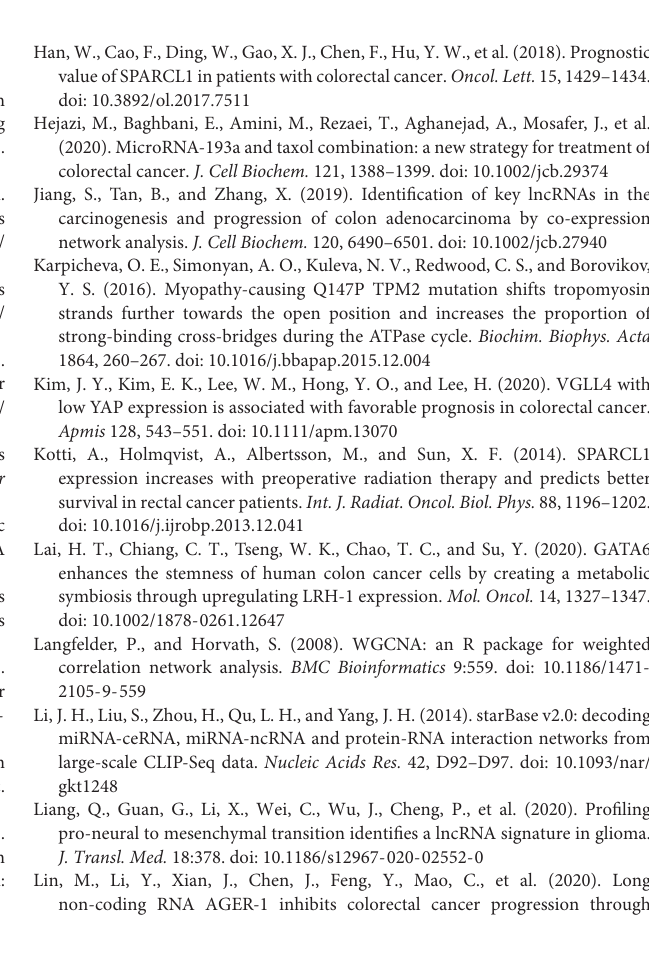
Supplementary Figure 1 | Clustering of samples to detect outliers. Supplementary Figure 2 | Sample clustering tree and soft threshold power analysis in the WGCNA. (A) The clustering was based on the expression data in the GSE17536 dataset ( n = 176). The color intensity was proportional to tumor pathological stage, histological grade, recurrence, and differentiated status. In recurrence status, red means cancer recurrence, white means no recurrence, and gray means unknown. (B) Scale independence analysis of the scale-free fit index for various soft-thresholding powers ( β ). The power of β = 4 was selected. (C) Analysis of the mean connectivity for various soft-thresholding powers. determination of soft-thresholding power by analyzing network topology for thresholding powers from 1 to 20. (D) Checking the scale free topology when β = 4. K, connectivity; p(k), possibility of the connectivity. Supplementary Figure 3 | Dendrogram of all differentially expressed genes clustered based on a dissimilarity measure (1-TOM). Each branch in the figure represented one gene, and the colors below represented co-expression modules. Supplementary Figure 4 | Module clusters for CRC recurrence. There are total 19 Module memberships vs. gene significance clusters for CRC recurrence. Supplementary Figure 5 | Correlation of the key turquoise module with CRC recurrence. Scatter plot of the correlation between MEturquoise membership and gene